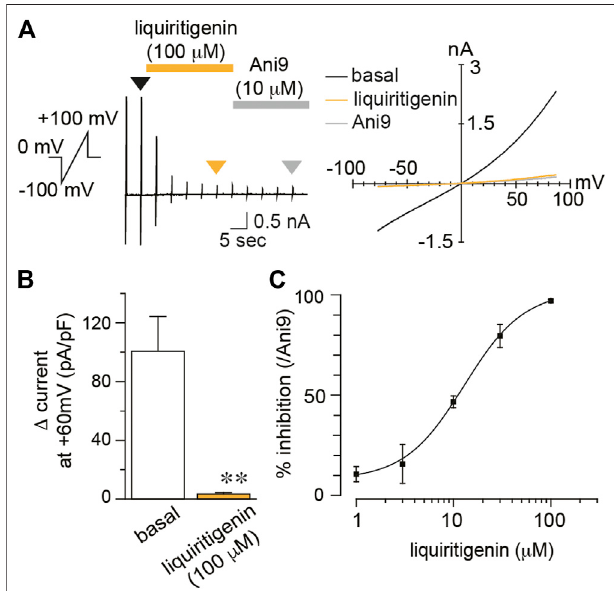
FIGURE 3 | The inhibitory effects of liquiritigenin on human TMEM16A (A) A typical trace and current-voltage curves of chloride currents during the application of 100 µM liquiritigenin to HEK293T cells expressing hTMEM16A. Typical current-voltage curves at the time indicated by black (basal), yellow (liquiritigenin), and gray (Ani9) arrowheads (B) Comparison of the Δ currentinHEK293T cellsexpressing hTMEM16Aat+60 mV(n (cid:2) 6 cells).Data are shown as the mean ± SEM; ** p < 0.01, Wilcoxon matched-pairs signed rank test (C) A dose-response curve for liquiritigenin-induced inhibition of hTMEM16A currents at +60 mV (n (cid:2) 5 – 6 cells). The IC 50 was 12.89